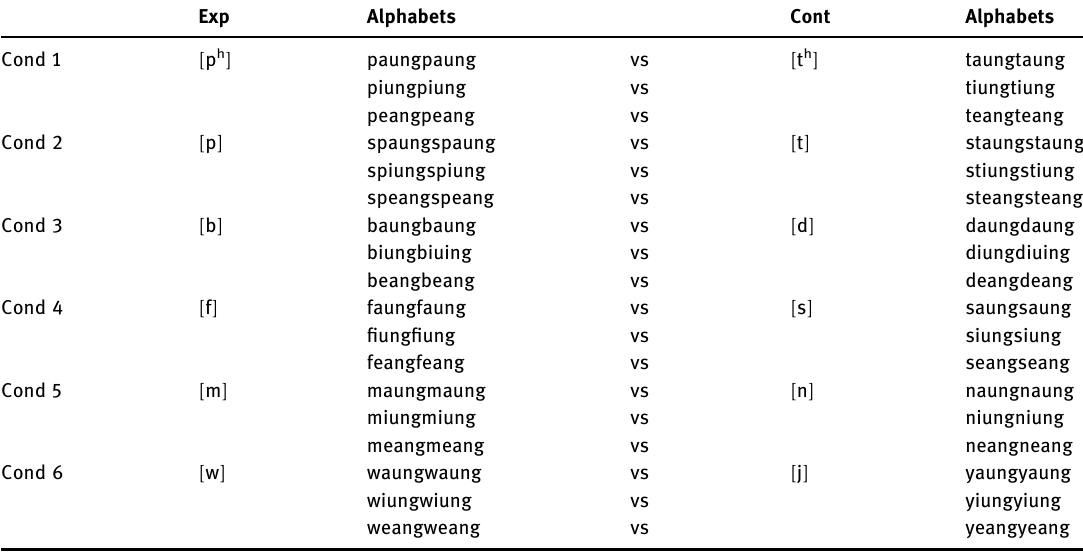
Table 2: Pairs of stimuli ( English )